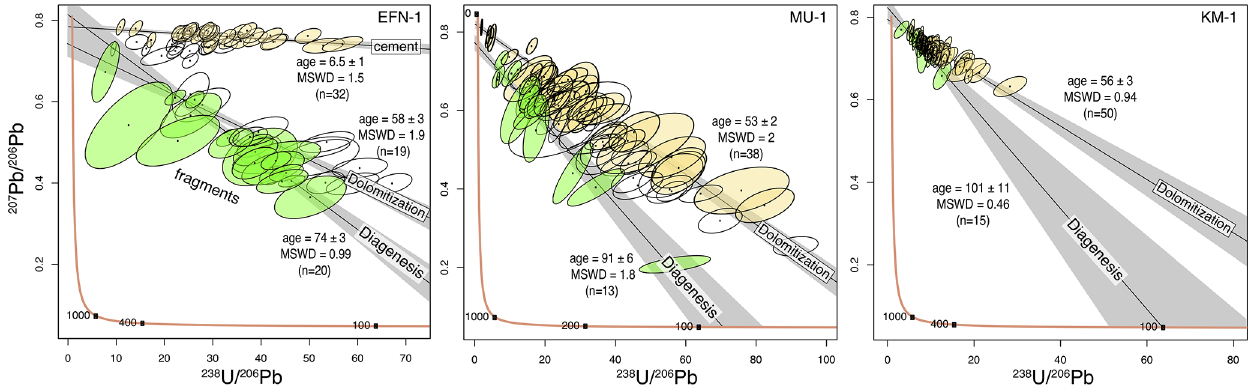
Figure 10. Age interpretation of U–Pb results for samples EFN-1, MU-1, and KM-1.